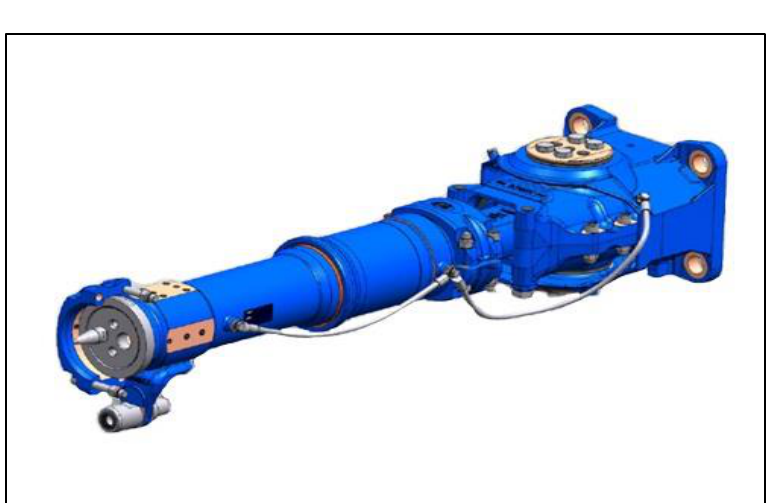
Figure 2. Front and rear coupler [12].